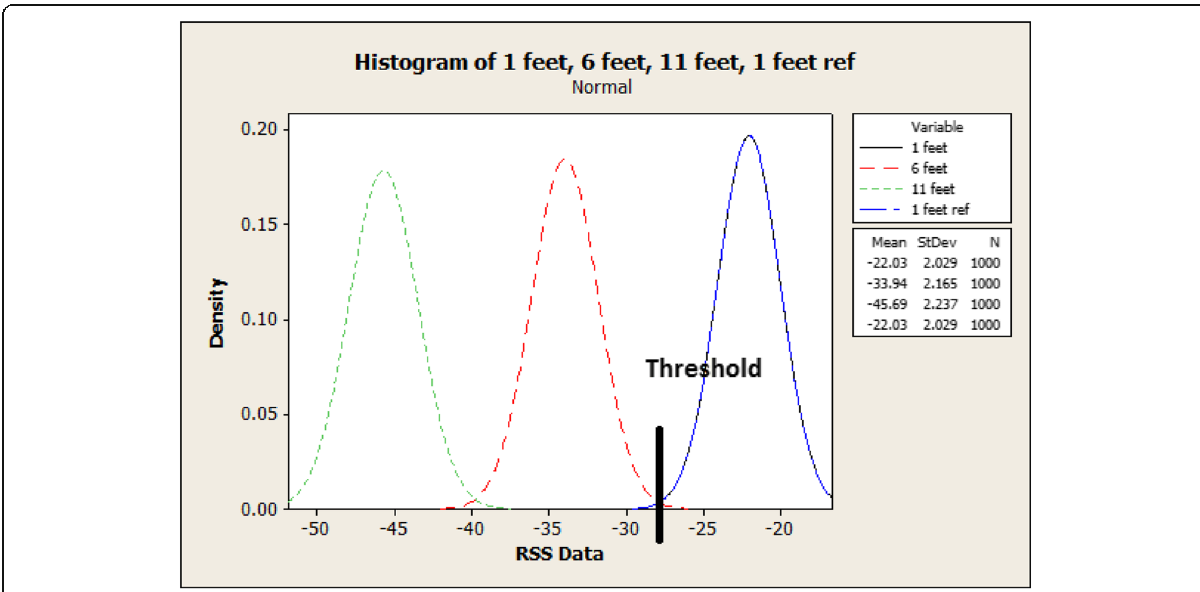
Fig. 6 Threshold with confidence interval graph. Represents the histogram values of 1, 6 and 11 ft. The x -axis shows the density value of the data, while the y -axis shows the RSS data. The figure also displays the mean and standard deviation of the three separate instances taken into consideration. The confidence interval with the threshold value has also been calculated statistically